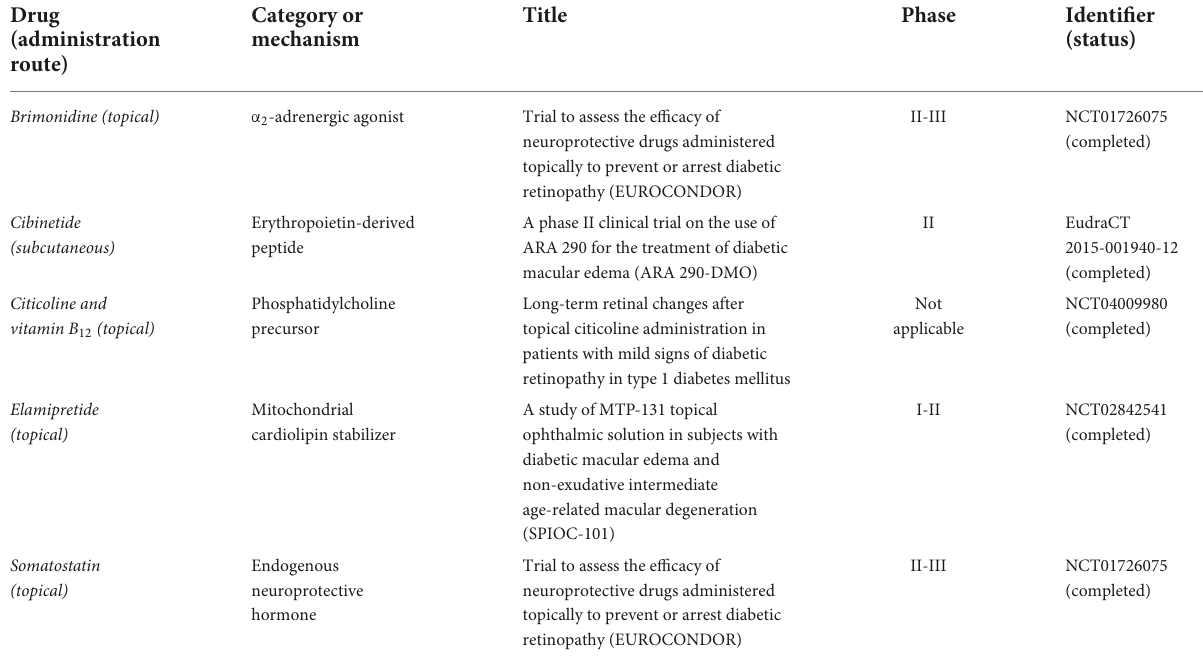
TABLE 3 Clinical trials on novel drugs targeting neurodegeneration in diabetic